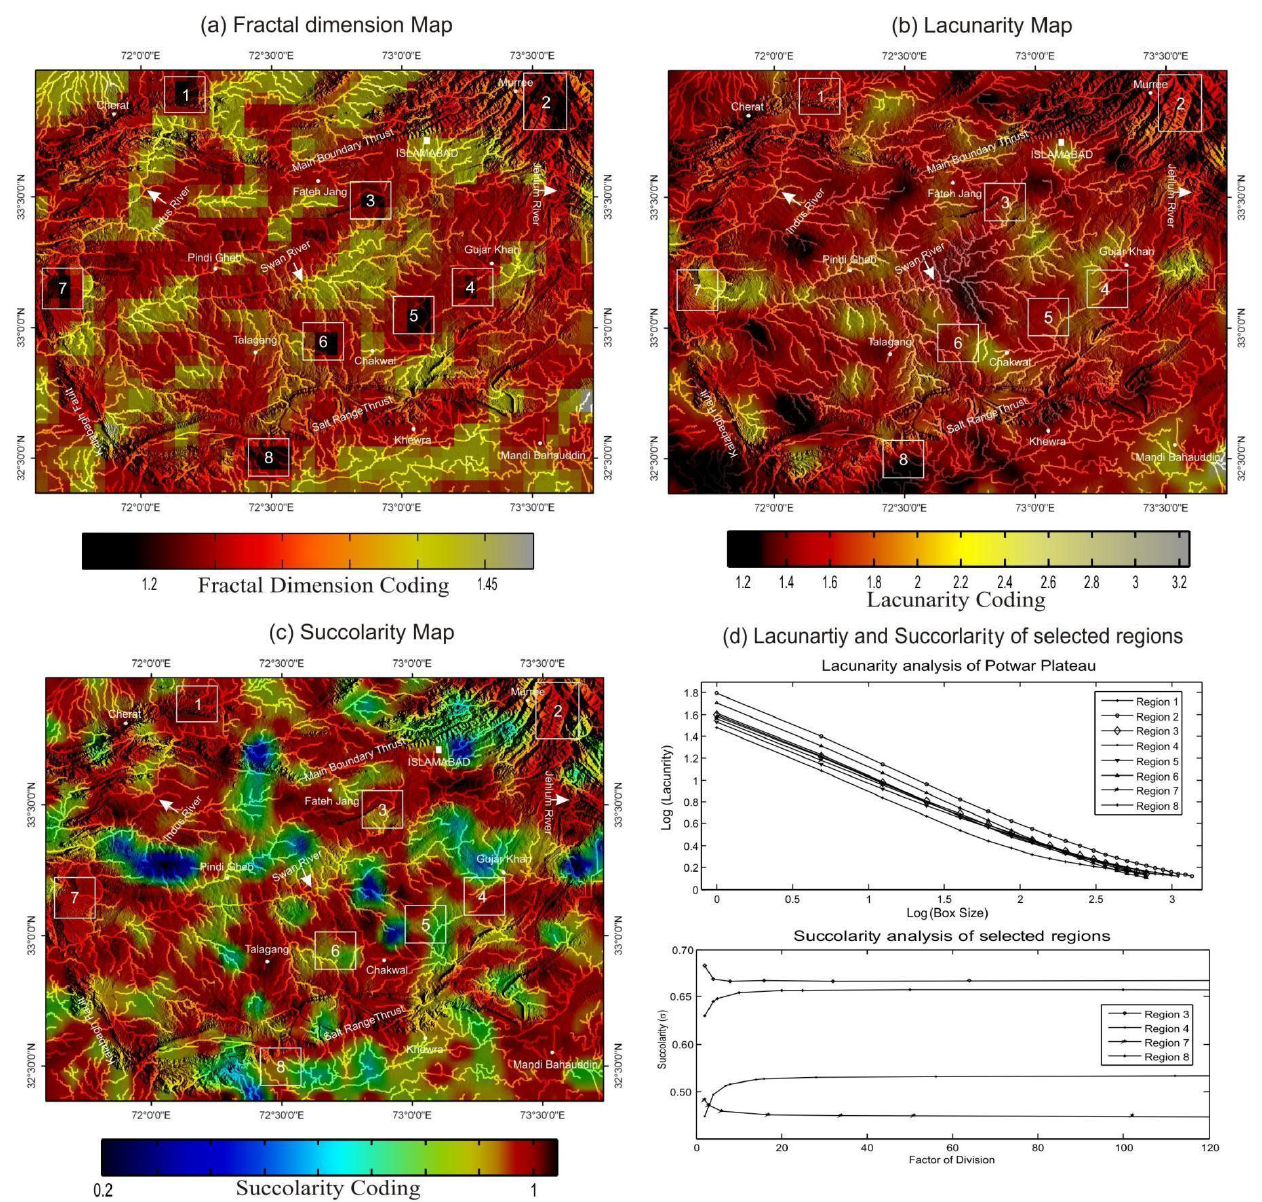
Fig. 4. (a) Fractal dimension distribution map of the study area. The low values of fractal dimension represent highly deformed regions. Eight sites with low values of fractal dimension are highlighted in all maps. (b) Lacunarity distribution map of the study area where high lacunarity values represent the regions with high vulnerability of surface deformation. (c) Succolarity distribution map of the study area. The drainage network is also shown in the background. The low values of succolarity are in regions of high drainage density. (d) Lacunarity and succolarity curves of the selected regions were used to differentiate the relative vulnerability of surface